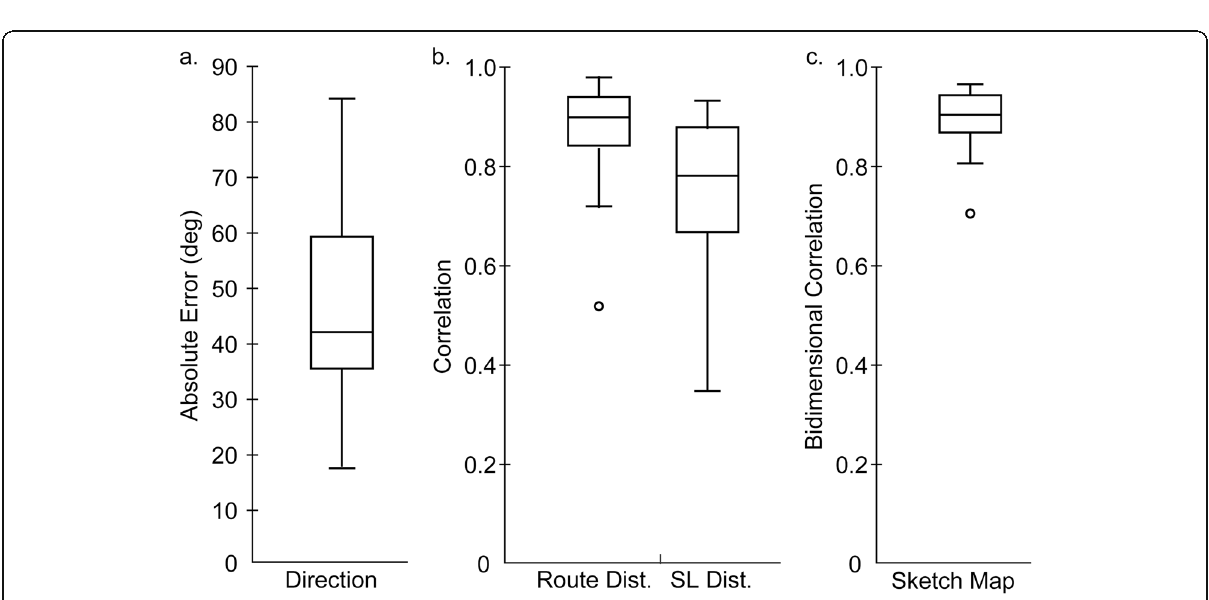
Fig. 8 Boxplots of direction estimates ( a ), distance estimates ( b ), and sketch maps ( c ), for the participants with a poor sense of direction. Each box extends from the first to the third quartiles, with an internal horizontal line across the box indicating the median. The whiskers extend to the highest and lowest values within 1.5 times the interquartile range. Values outside the range are depicted by circles. SL Dist., straight-line